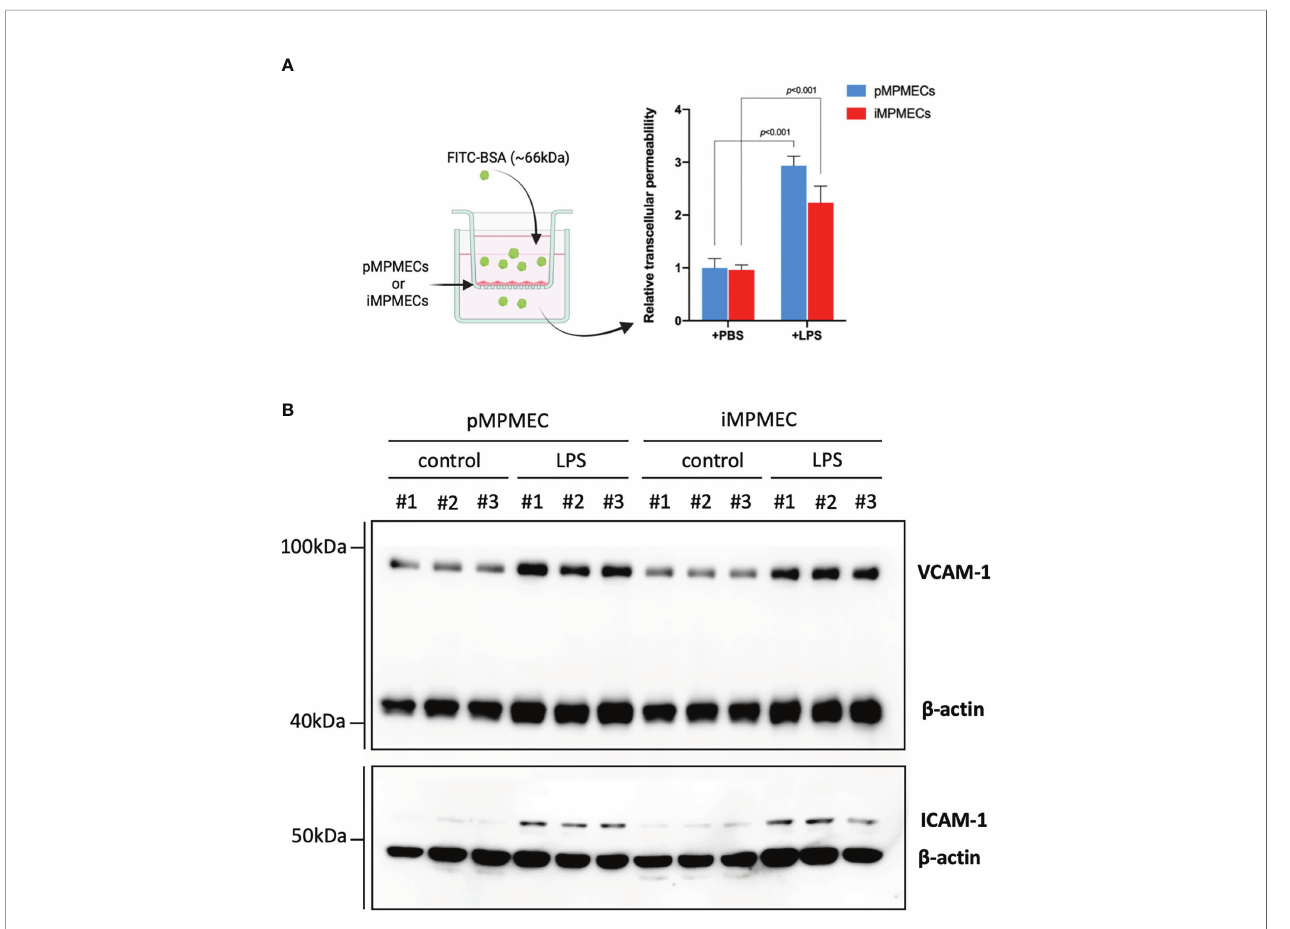
FIGURE 7 | Immortalized mouse pulmonary microvascular endothelial cell (iMPMEC) function and response to in fl ammatory treatment. (A) The permeability of lipopolysaccharide (LPS)-treated primary mouse pulmonary microvascular endothelial cells (pMPMECs) and iMPMECs monolayers grown on 0.4- m m fi lters is measured by the passage of fl uorescein isothiocyanate – bovine serum albumin probes added to the top well at the beginning of the experiment. The absorbance at 550 nm at 24 h later is measured in the top and bottom wells, n = 3. The p -values shown are determined by Student ’ s t -test. (B) Western blotting analysis to detect the in fl ammatory-related protein VCAM-1 and ICAM-1 expression of LPS-treated pMPMECs and iMPMECs. Cells are collected, lysed, and denatured with loading buffer. The samples were loaded into FuturePAGE gel, and the gel was run as recommended by the manufacturer. The proteins in the gel are transferred to polyvinylidene fl uoride membranes. The membranes are blocked with 5% nonfat dry milk at room temperature for 2 h and then incubated with primary antibodies at 4°C overnight. On the next day, the membranes were washed with 1X Tris-buffered saline with 0.1% Tween ® 20 detergent for three times and then incubated with secondary antibody at room temperature for 1 h. The membranes were washed, and images of the enhanced chemiluminescence substrate were acquired; n =